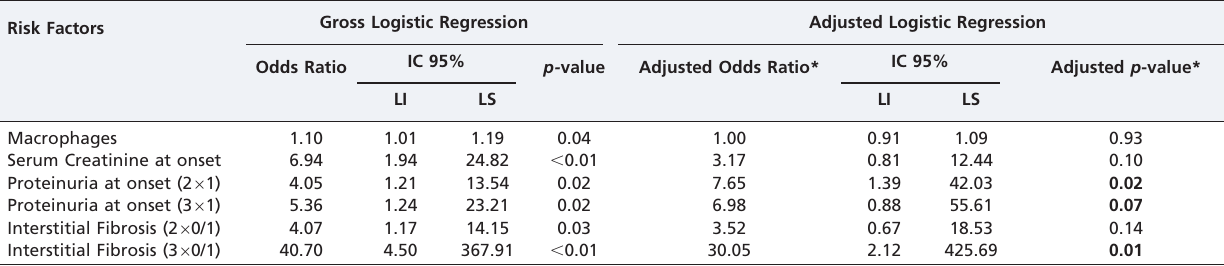
Table 2 - Risk factors for unfavorable clinical course according to the multivariate